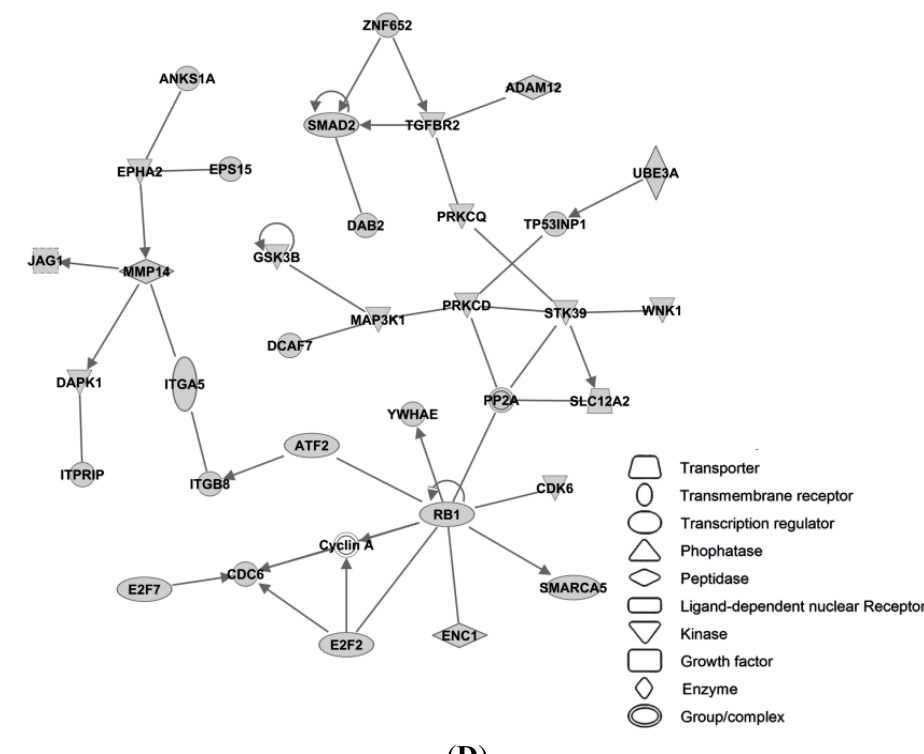
Figure 6. Top networks of miR-30c, network 1 ( A ), miR-10a, network 1 ( B ), miR-342, network 1 ( C ) and miR-26a, network 1 ( D ). Shown here are networks with the highest scores calculated by IPA, showing direct targets of the miRNAs. Shaded boxes refer to direct targets whilst clear boxes refer to indirect targets of the specific